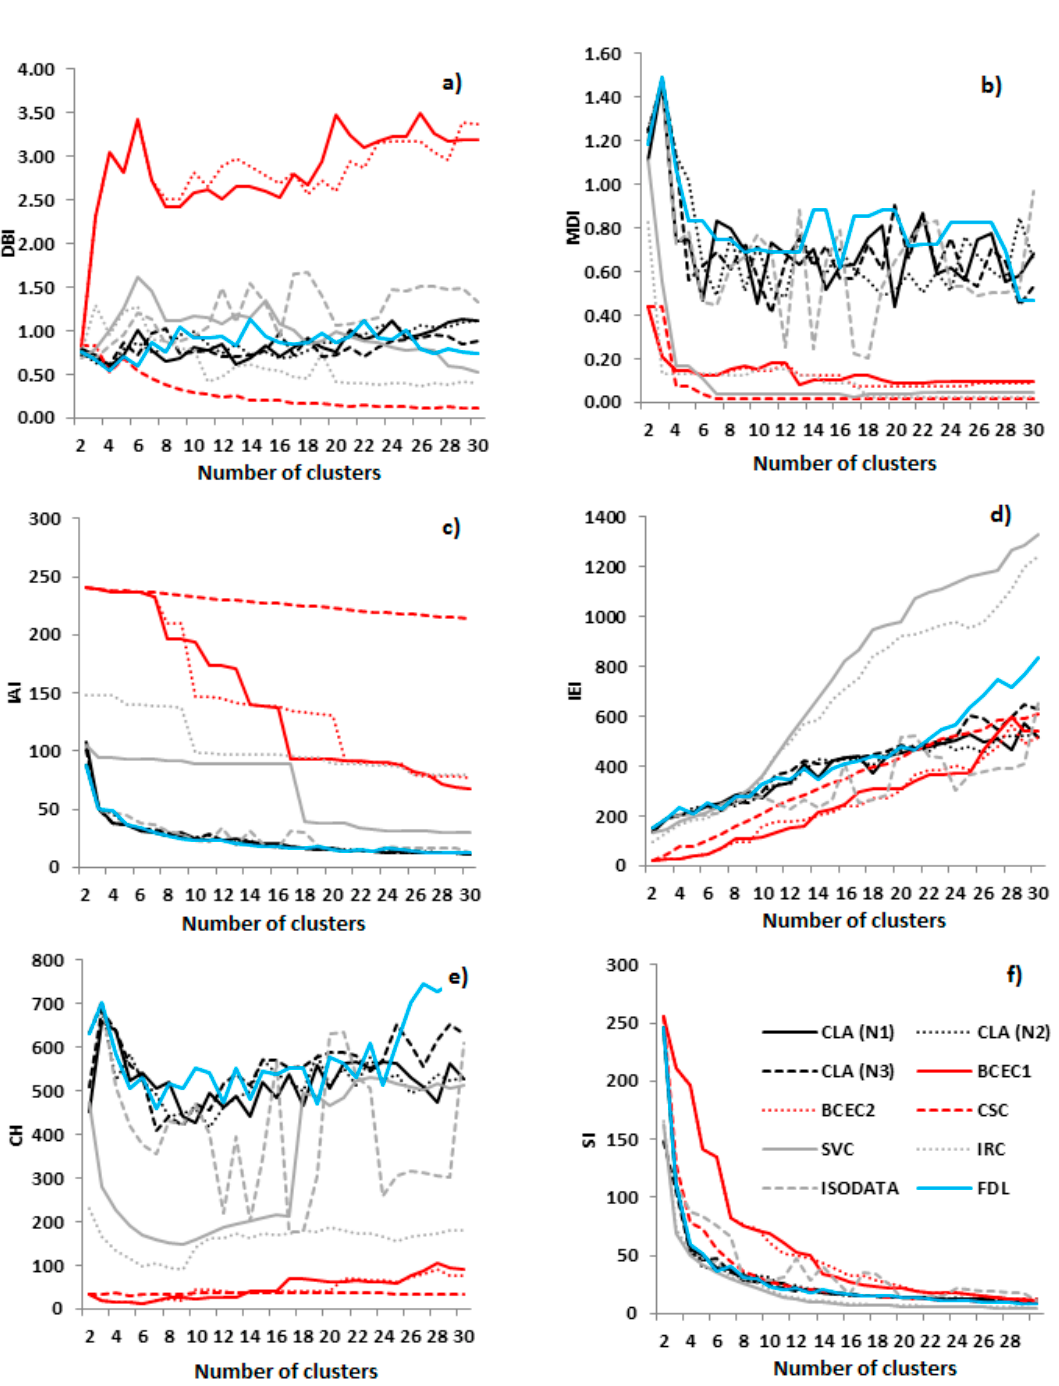
Figure 2. Comparison of the partitional algorithms using: ( a ) DBI, ( b ) MDI, ( c ) IAI, ( d ) IEI, ( e ) CH, ( f ) SI.